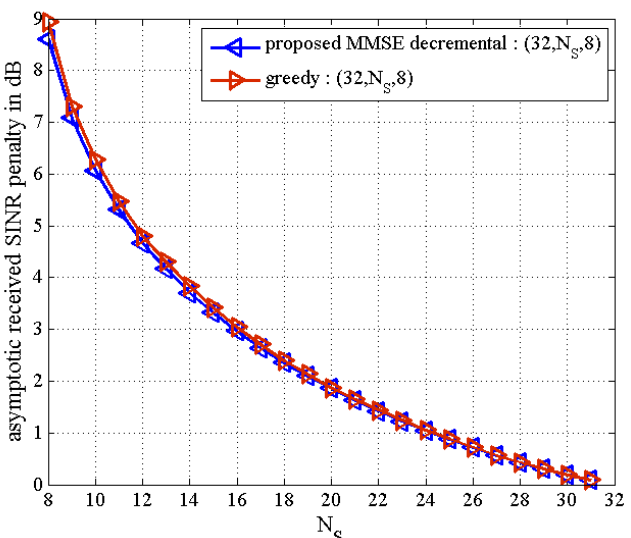
Figure 8. Received SINR loss for MU–STLC system with TAS selection for ( 32, N S ,8) .